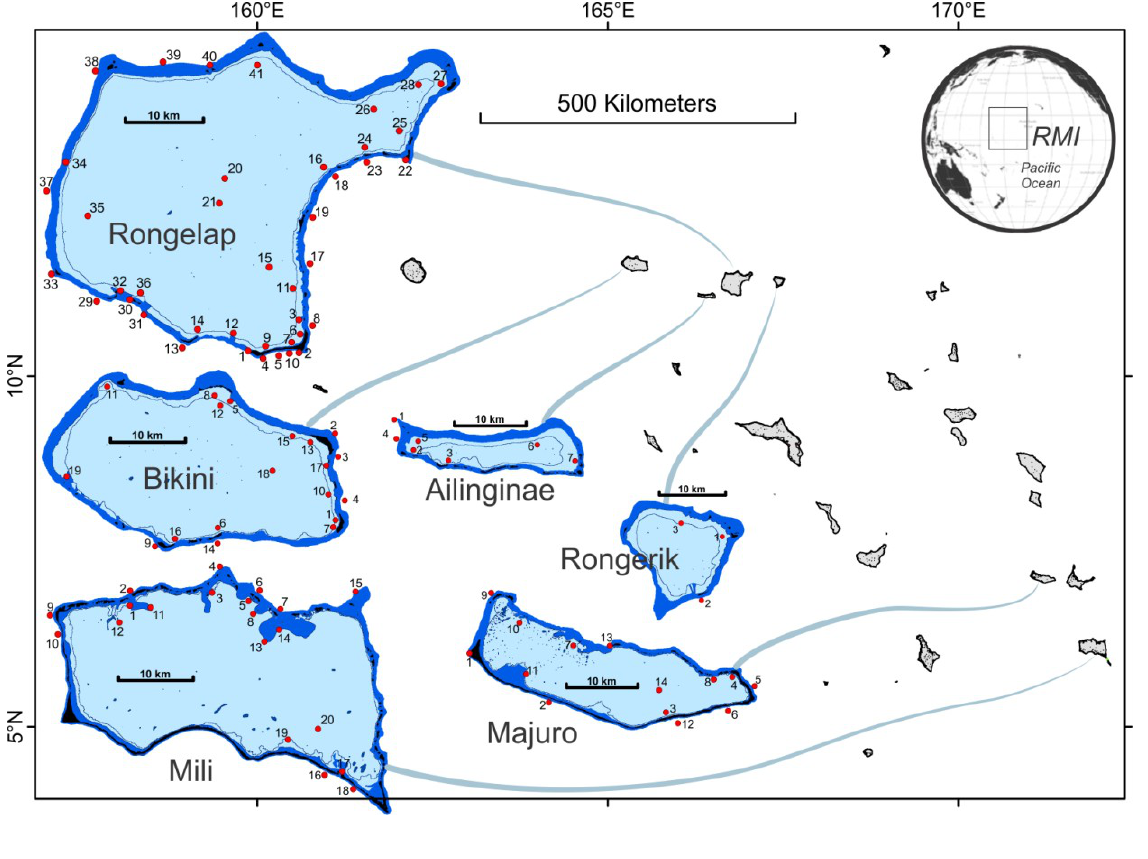
Figure 1. Map of the Marshall Islands with insets of atolls showing survey sites. Site numbers correspond to those provided in Table S2, which contains coordinates. Base map from Millennium Coral Reef Mapping project [24]